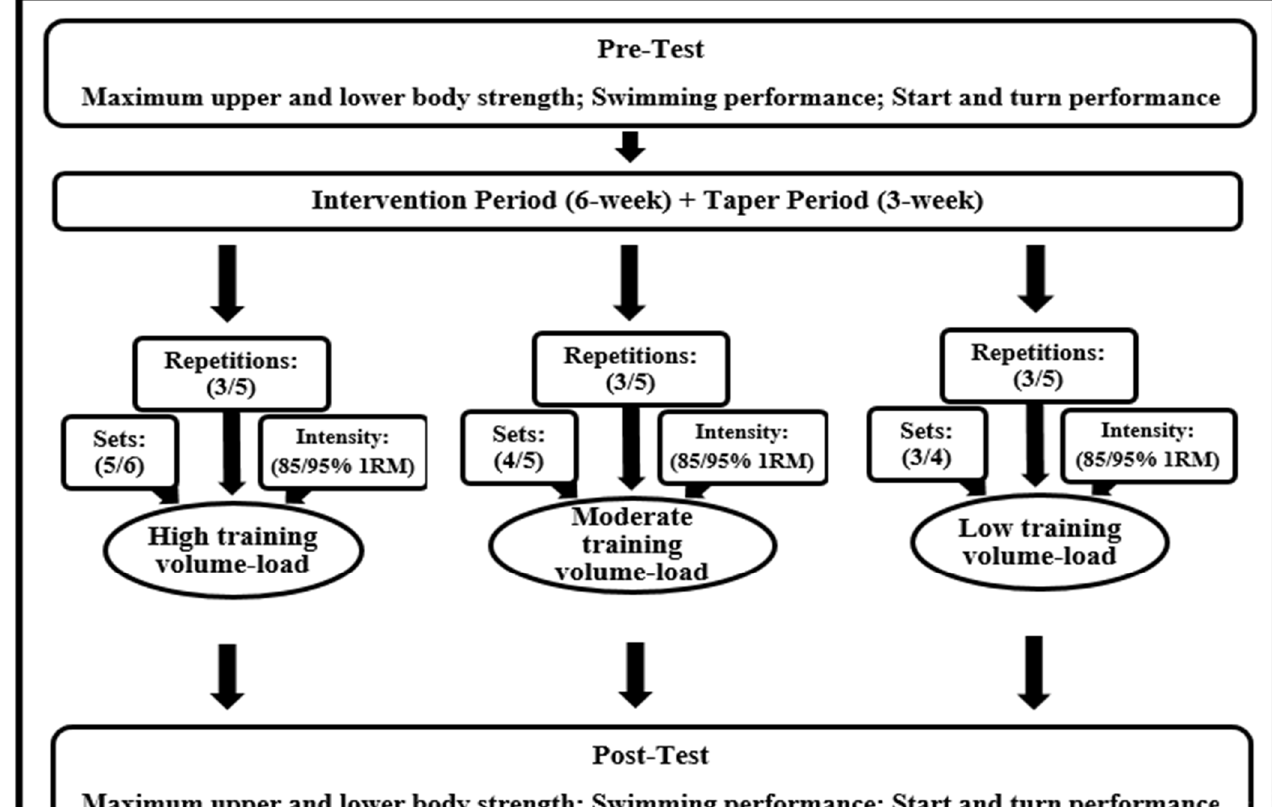
Figure 1. Description of the study design for the three groups.